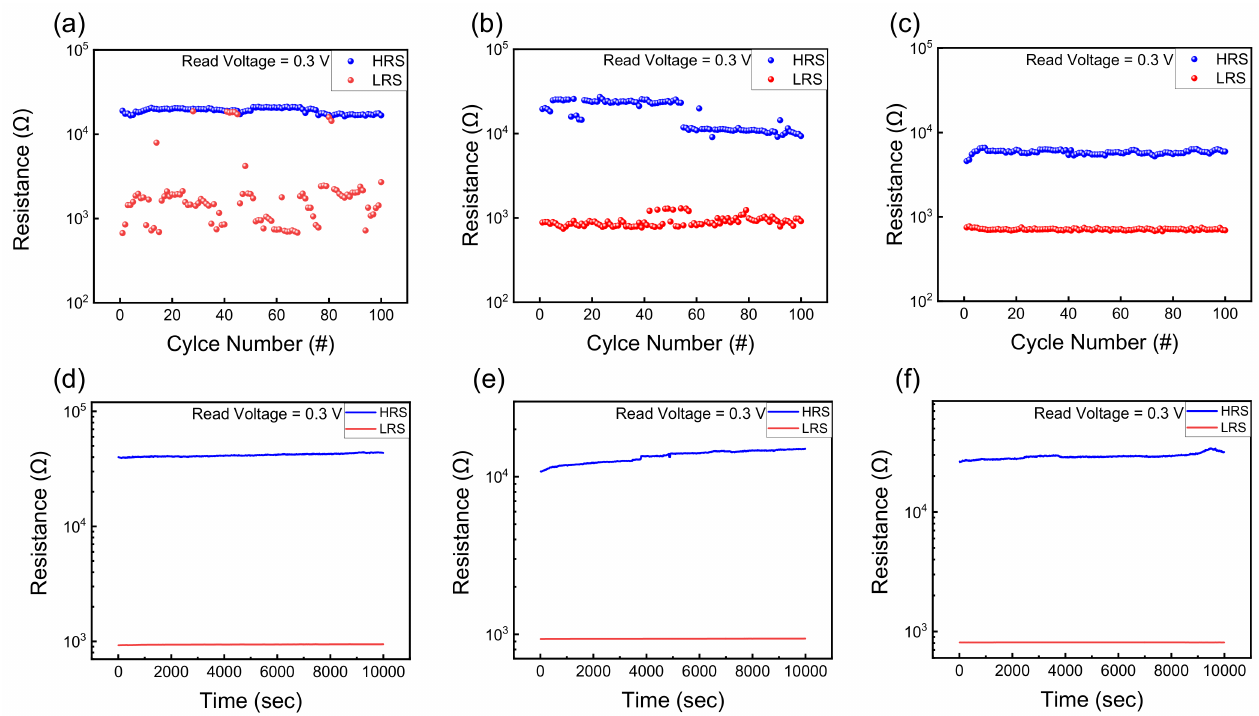
Figure 4. Endurance data of ( a ) CC = 0.5 mA, ( b ) CC = 1 mA and ( c ) CC = 5 mA. Retention data of ( d ) CC = 0.5 mA, ( e ) CC = 1 mA and ( f ) CC = 5